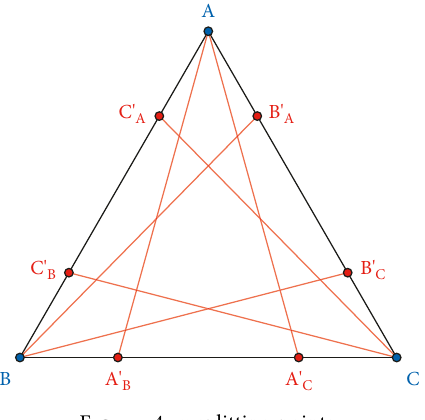
Figure 4: α -splitting